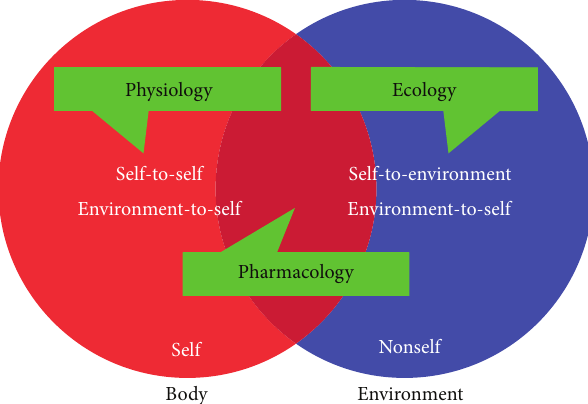
Figure 1: Connections between physiology, ecology, and pharmacology. At best the distinction between an organism’s physiology and its overall ecology can be ambiguous, though with body-pharmaceutical interactions representing one aspect of their interface. Such chemicals specifically can be viewed as abiotic components of an organism’s environment, ones that have made contact with an organism’s tissue, as can also toxins. Shown are body interactions not just with self (as body) but with nonself as well (as environment), with emphasis in physiology on the impact of these interactions on the functioning of self. Ecology also is the study of interactions between self and nonself, but with the consequences of such interactions considered with emphasis on both self, as body, and nonself, as environment. Pharmacology too is the study of interactions between self and nonself (particularly “environment-to-self”), though as with physiology there is an emphasis on impact on self (again, as